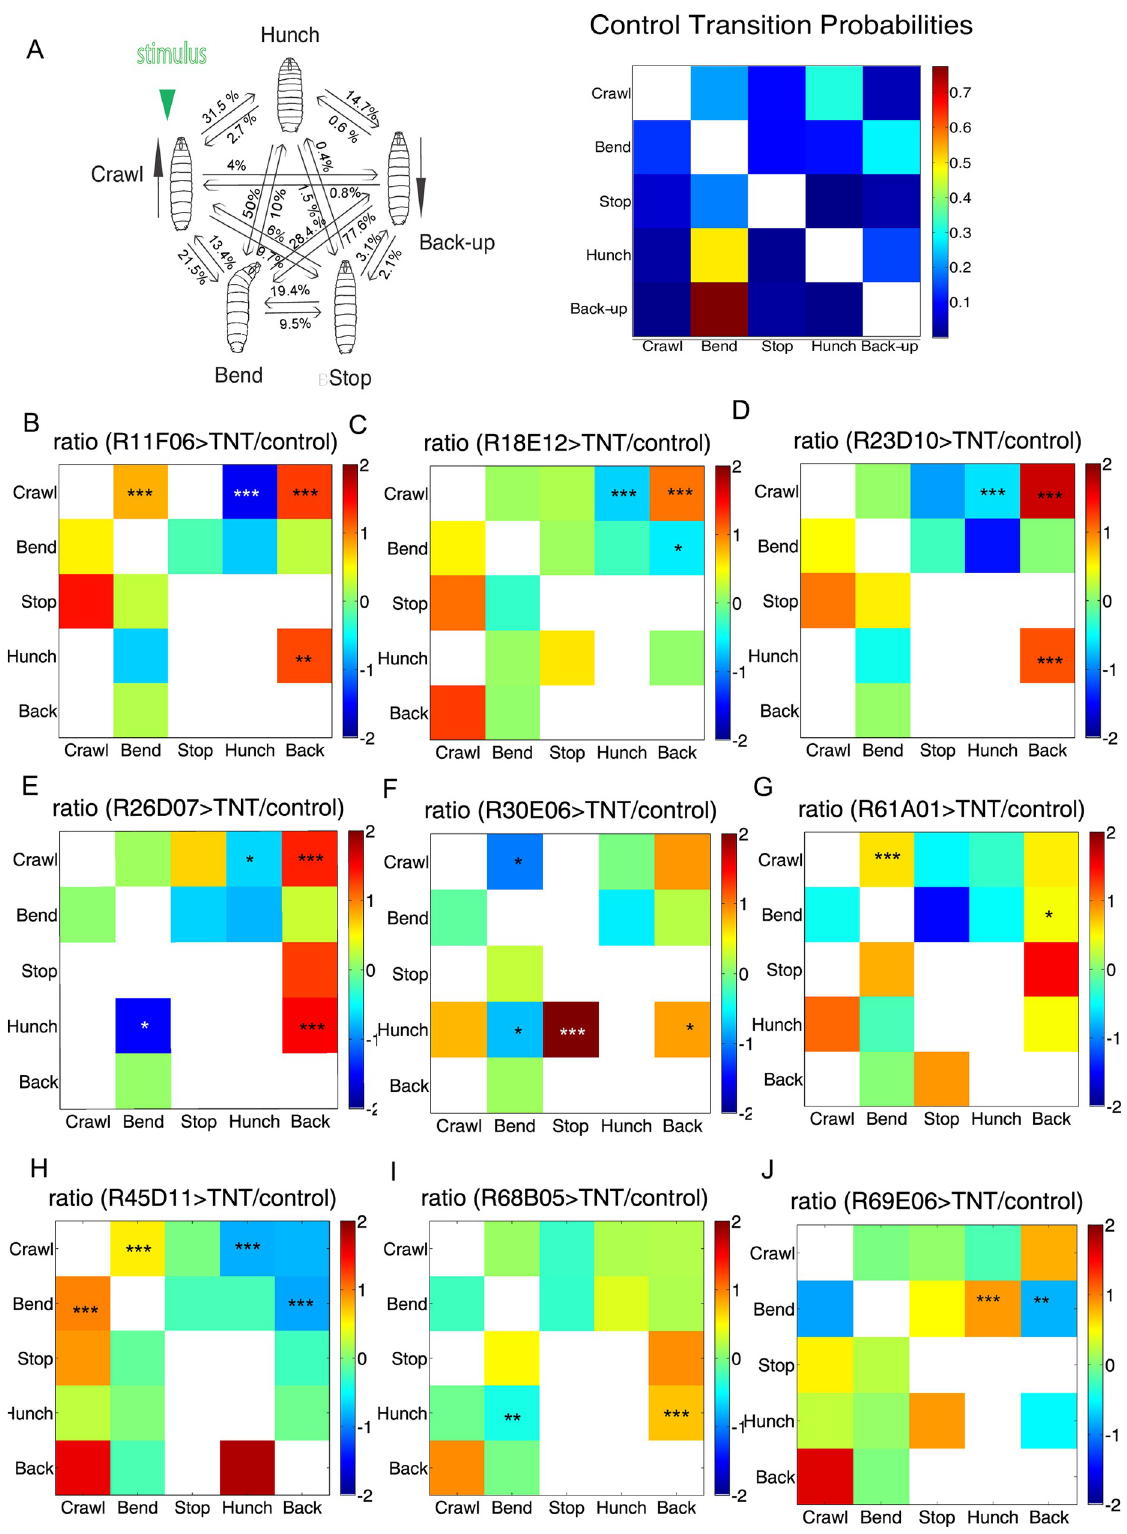
Fig 7. Transition probabilities phenotypes. A . Transition probabilities for the w;; attP2-TNT control B-J. ratio of transition probabilities for selected hit lines relative to the control B-G Examples of transition probability phenotypes for hit lines of competitive interaction hits